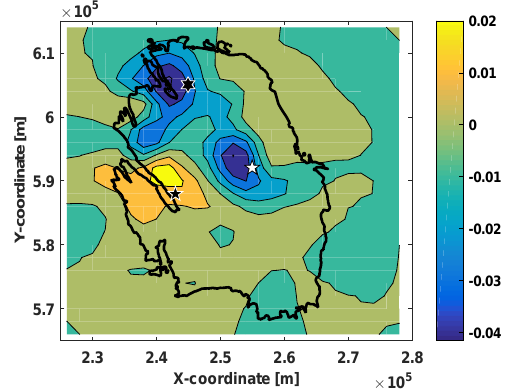
Figure 4. Effect of the compaction adjustment on the calculated subsidence in